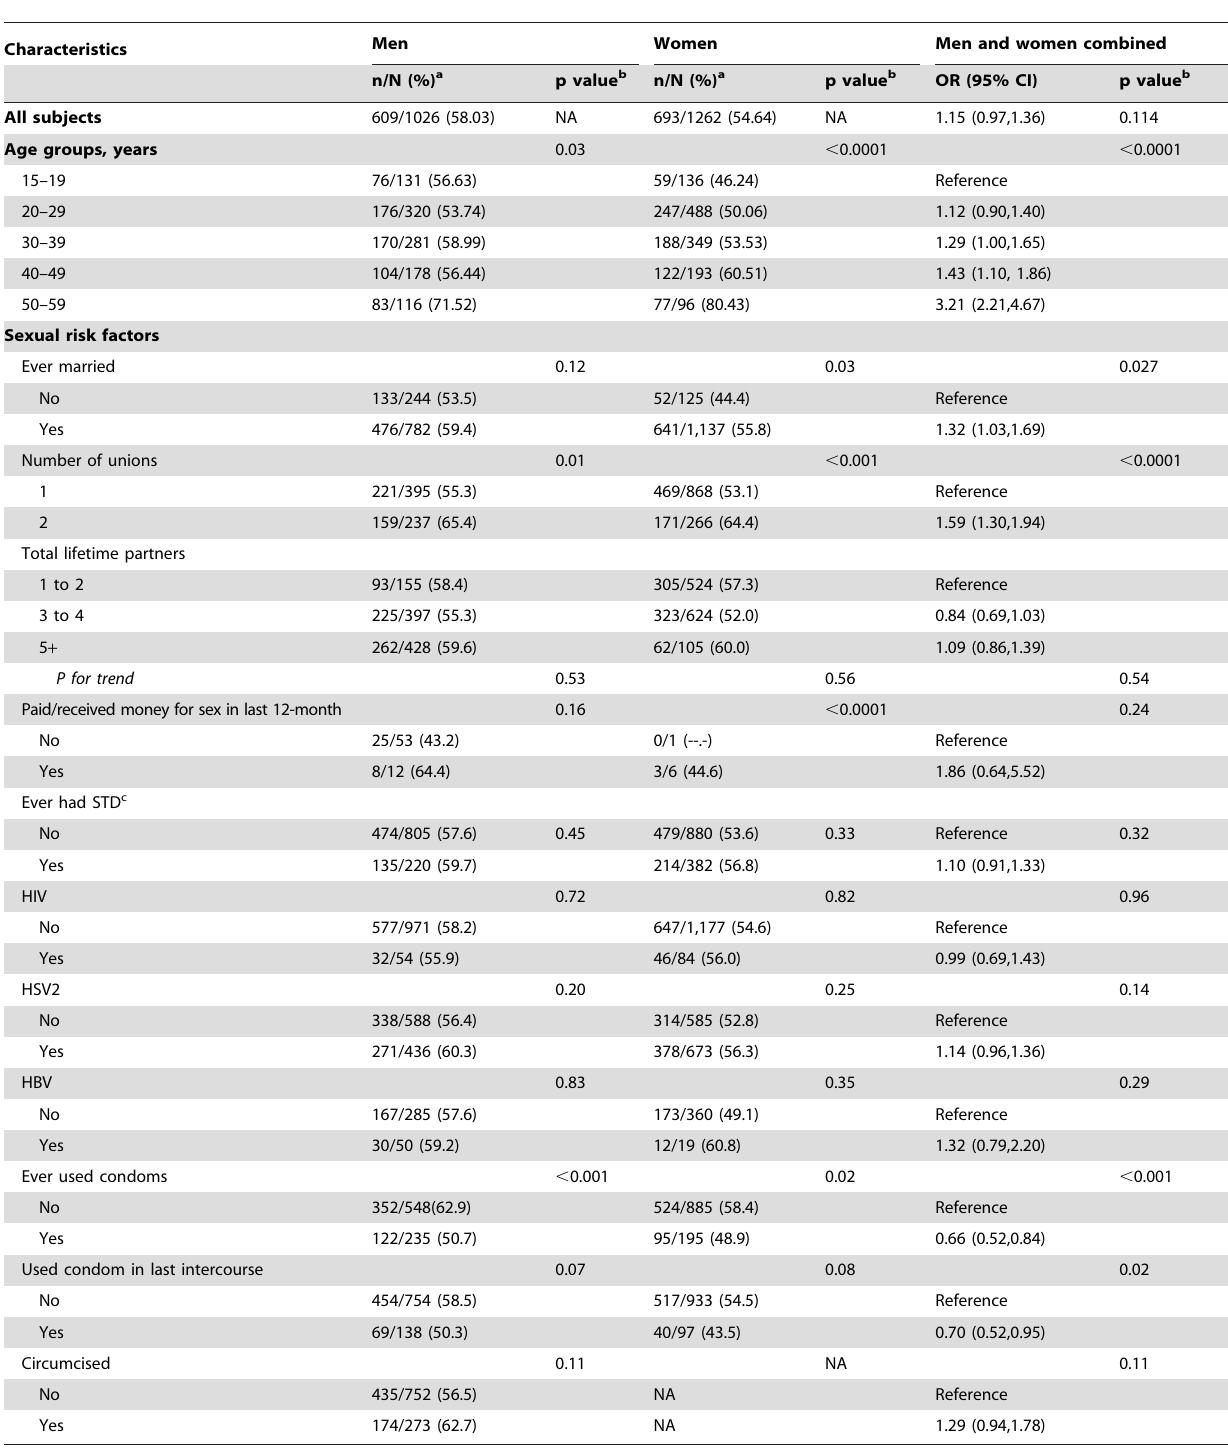
Table 1. Crude association between HHV8 seropositivity and demographical and sexual variables among sexually active adults in